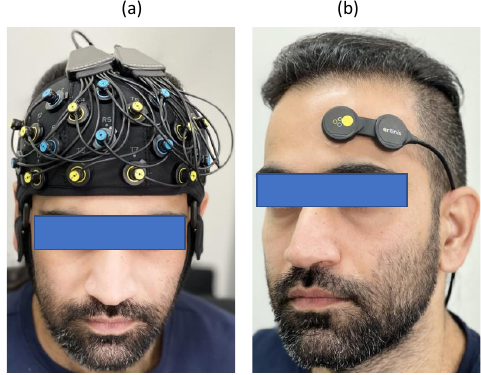
Figure 6. fNIRS optode placement for dataset I ( a ) and dataset II ( b ).